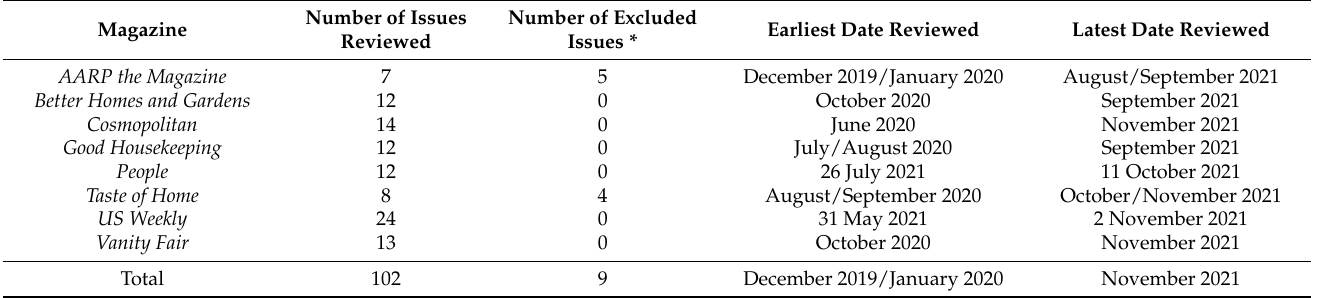
Table 1. Issues and dates of each magazine reviewed for inclusion of salt and iodized salt in the list of ingredients in magazines published between 2019 and 2021.